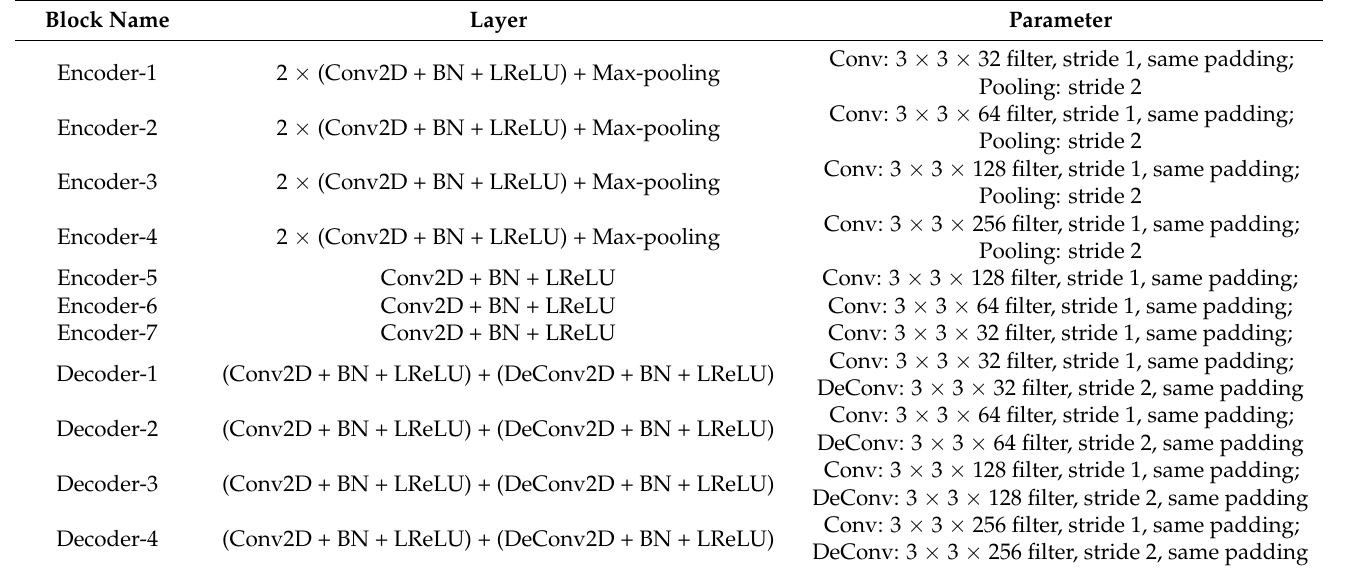
Table 1. The detailed network structure of multi-DL (multi-task deep